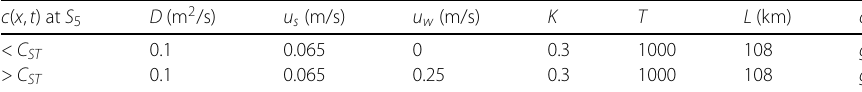
Figure 10 The numerical solution of simulation 3 by (cid:4) x = 0.1 and (cid:4) t = 0.05 for all 0 ≤ x ≤ 108 and 0 ≤ t ≤